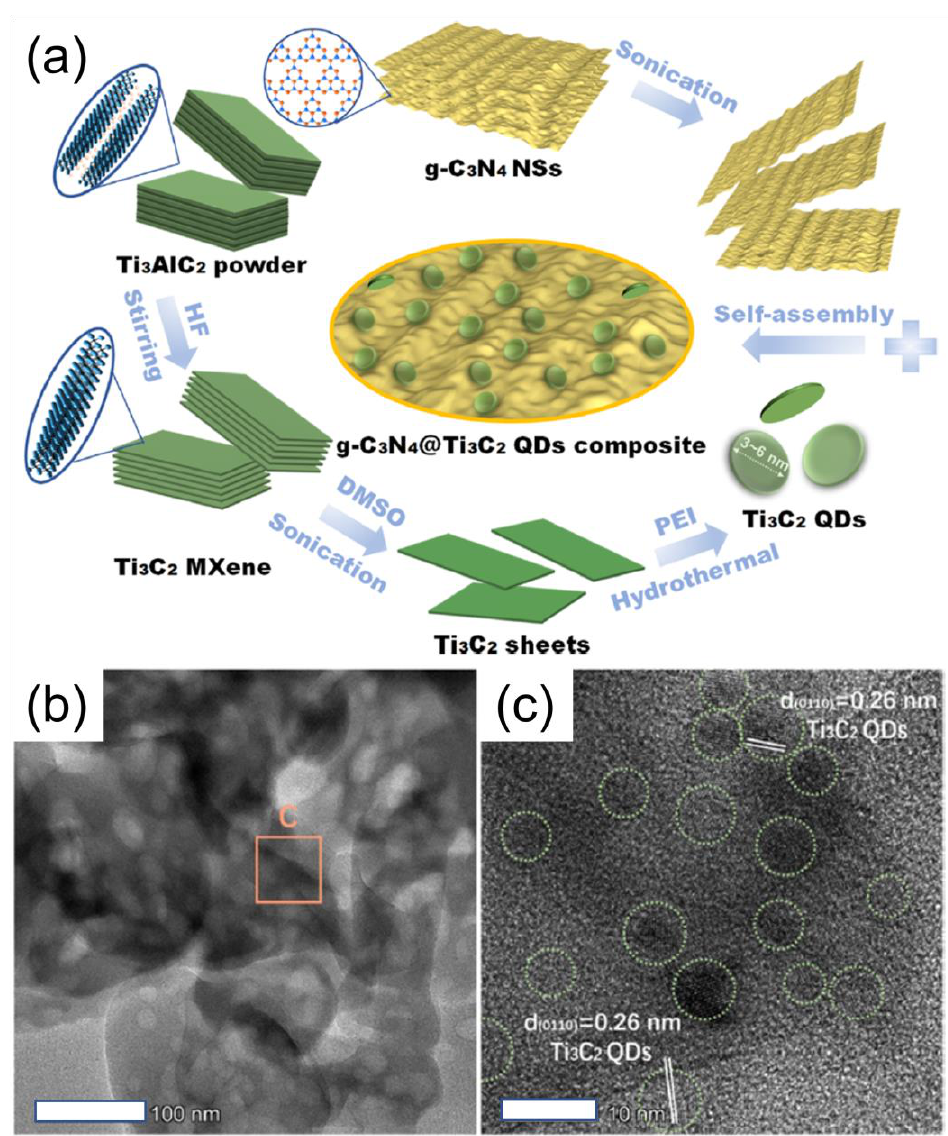
Figure 9. ( a ) Schematic description for the preparation of Mxene/g-C 3 N 4 composite using electro- static attraction approach and ( b , c ) TEK images of Mxene/g-C 3 N 4 composites. (Reprinted with permission from Ref. [148]. 2019 American Chemical Society).